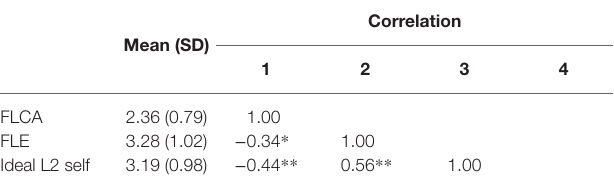
TABLE 3 | Descriptive statistics and